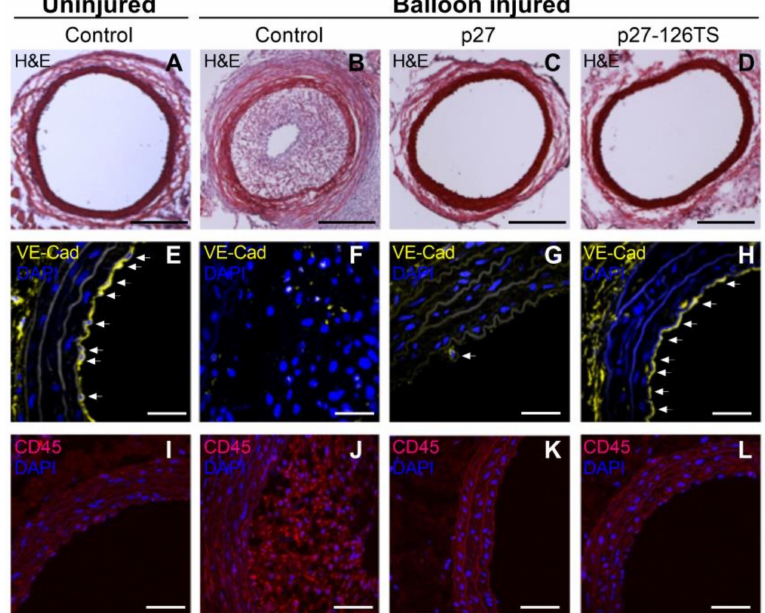
Figure 3. Treatment with p27-126TS prevents restenosis and allows for complete reendothelialization of the vascular wall. ( A – D ). Representative images of uninjured ( A ), or balloon injured rat carotid arteries treated with GFP ( B ), p27 ( C ), or p27-126TS ( D ) followed by hematoxylin and eosin (H&E) stain. Original magnification 10 × , scale bars represent 500 µ M. ( E – H ) Representative images of uninjured (E), or balloon injured rat carotid arteries treated with GFP ( F ), p27 ( G ), or p27-126TS ( H ) immunostained for vascular endothelial cell marker vascular endothelial-cadherin (VE-Cadherin). White arrows indicate VE-Cadherin positive endothelial cells. ( I – L ) Representative images of uninjured ( I ), or balloon injured rat carotid arteries treated with GFP ( J ), p27 ( K ), or p27-126TS ( L ) immunostained for the pan-inflammatory marker CD45. ( E – L ) Nuclei were counterstained with DAPI. Original magnification 60 × , scale bars represent 100 µ